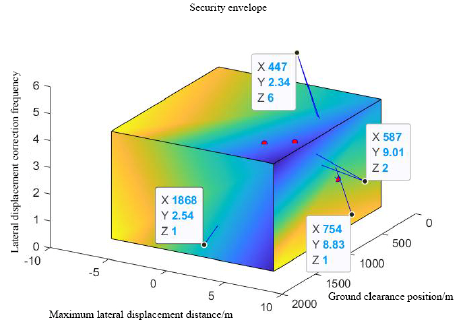
Figure 13. Safety envelope breakthrough.